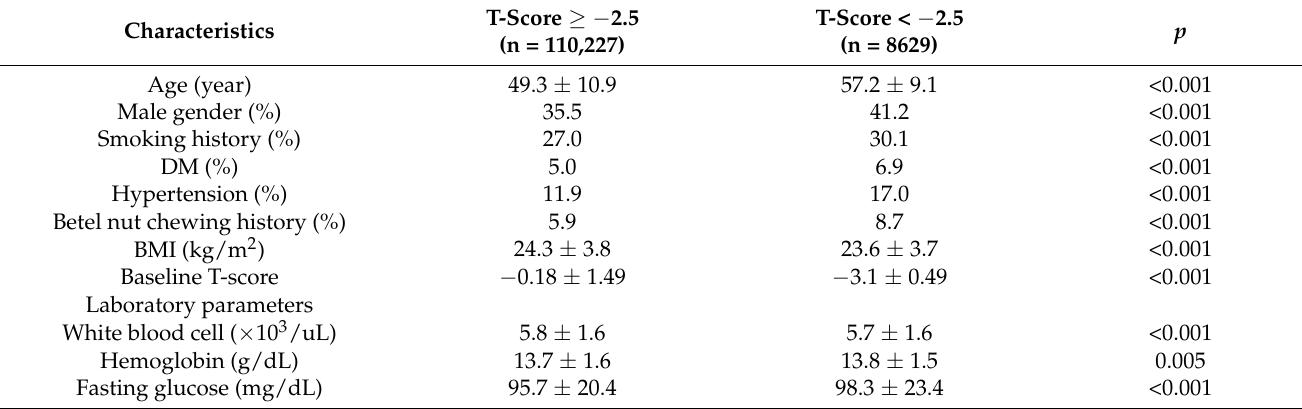
Table 1. Comparison of clinical characteristics among participants according to baseline calcaneus ultrasound T score ≥ − 2.5 or < −